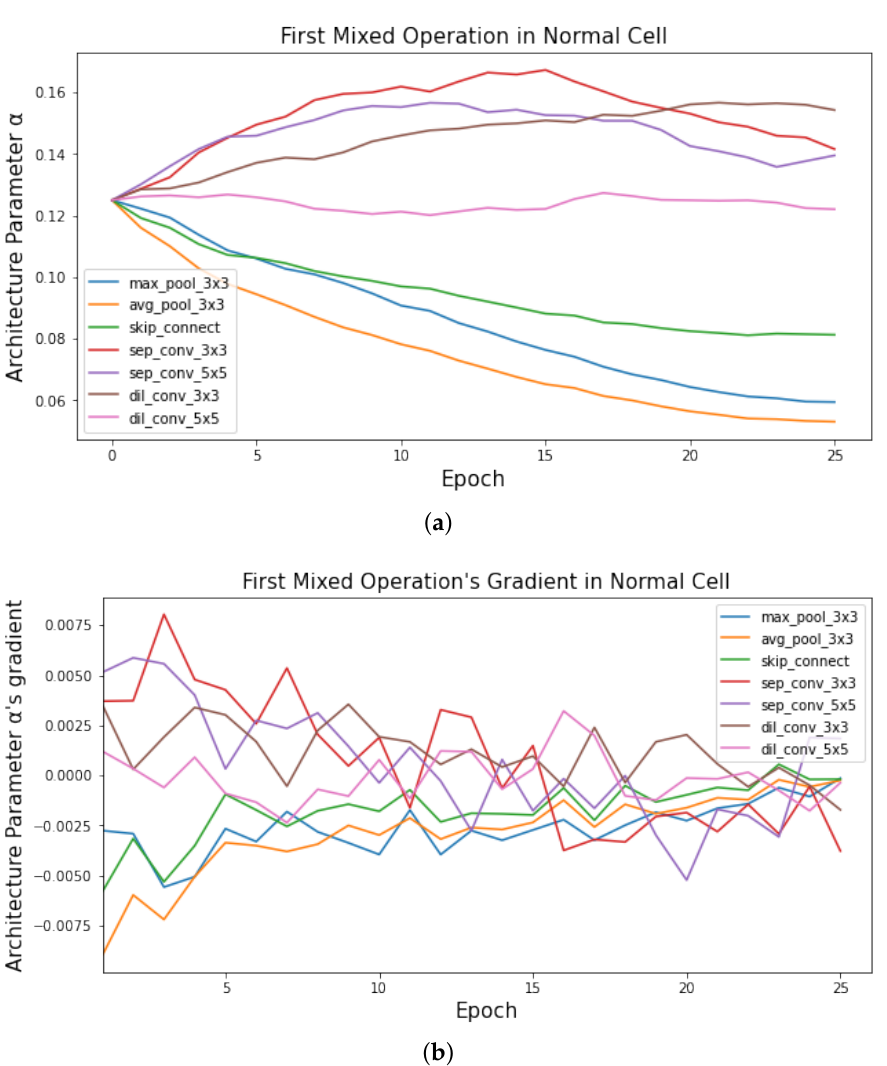
Figure 3. First mixed operation over stage 1 epoch. ( a ) Architecture parameter. ( b ) Gradient of the architecture